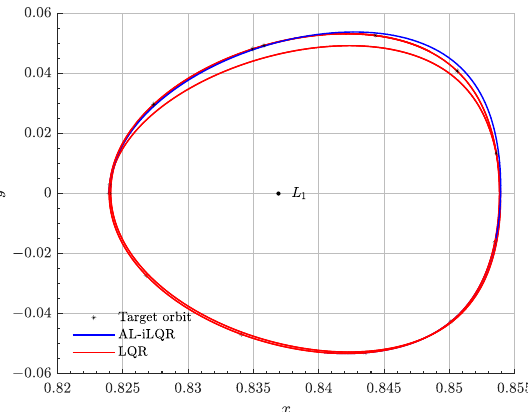
Figure 7. Rendezvous trajectory in the absolute configuration space for the AL-iLQR and LQR (RLLM)